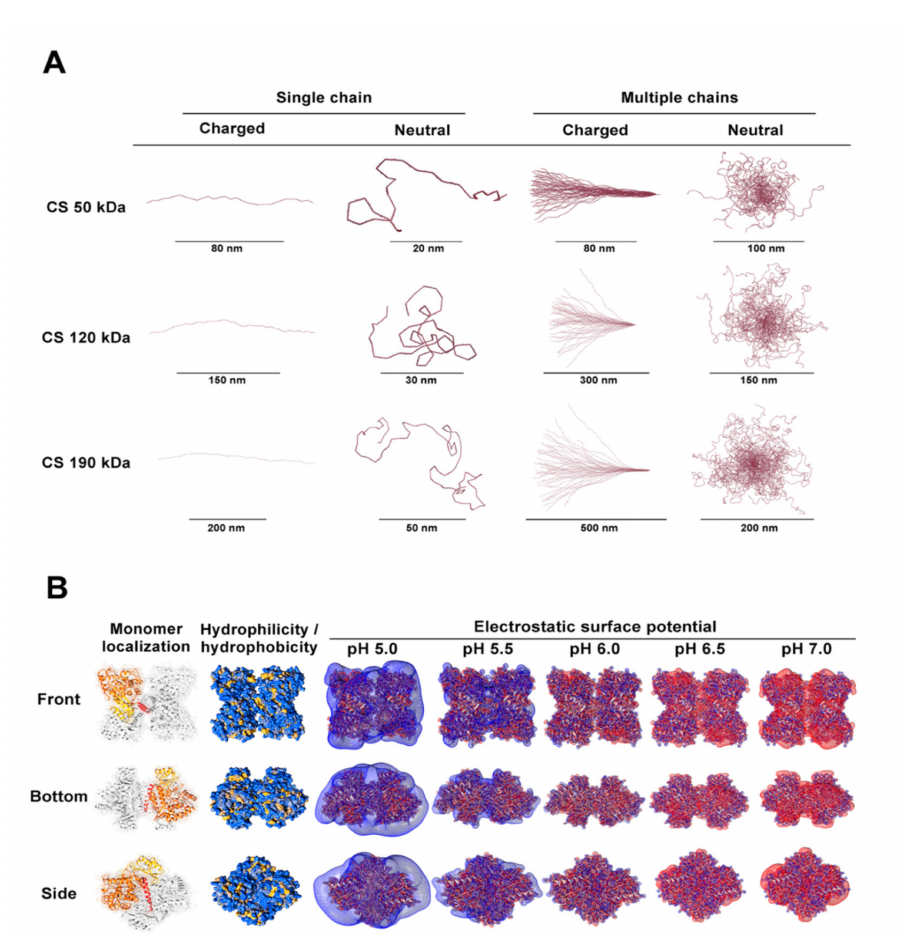
Figure 3. In silico assessment of chitosan (CS) hydrodynamics and human phenylalanine hydroxylase (hPAH) hydrophilicity and electrostatic surface potential at different pH values. ( A ) Hydrodynamic behavior of charged/neutral CS polymeric single and 50 chains at the minimum (50 kDa), maximum (190 kDa) and average (120 kDa) CS MW used in this study. ( B ) In silico evaluation of hydrophilicity/hydrophobicity and electrostatic potential of tetrameric hPAH; (Monomer localization) regulatory (yellow), catalytic (orange) and oligomerization (red) domain of a monomer; (hydrophilicity/hydrophobicity) hydrophilic (blue) and hydrophobic (yellow) hPAH residues; (Electrostatic surface potential) positive surface potential (blue) and negative surface potential (red). For further details see Materials and